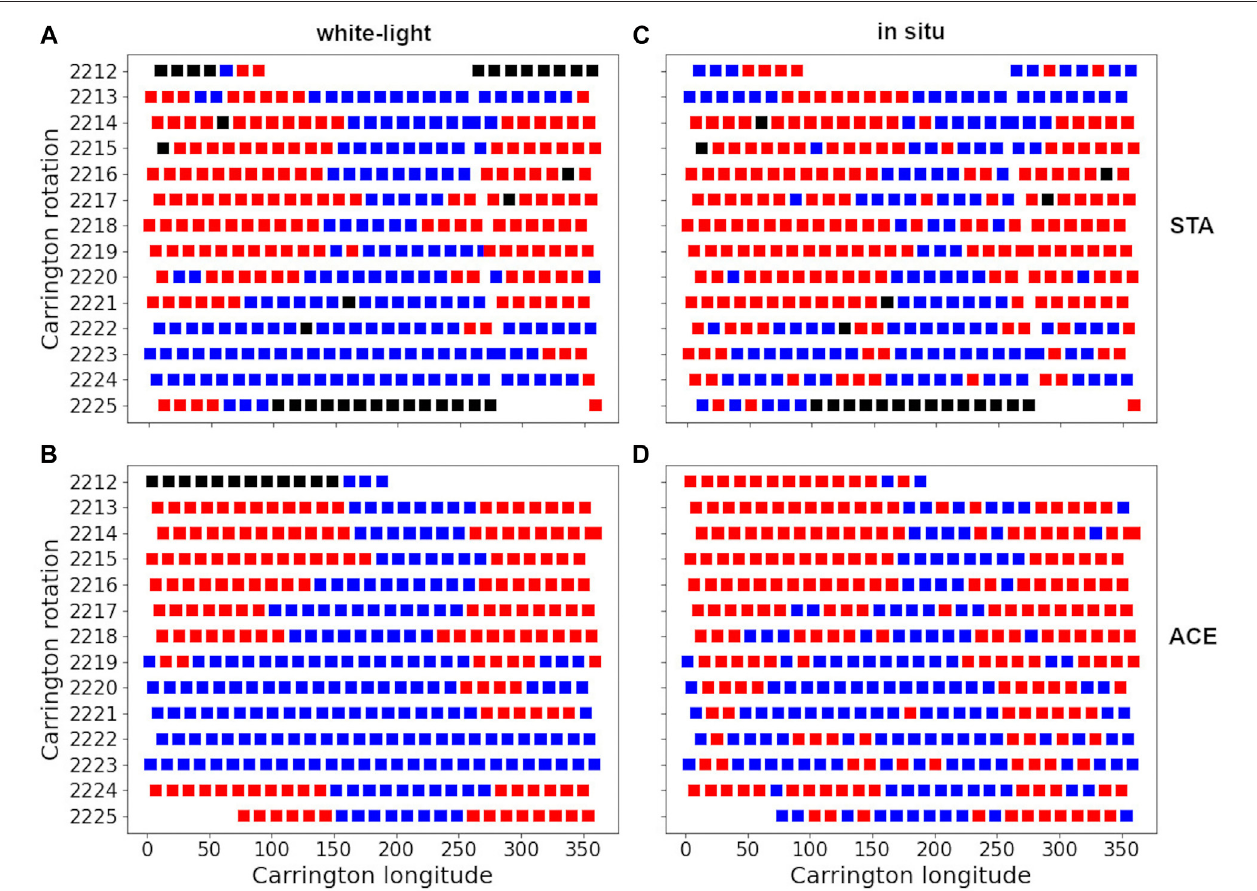
FIGURE 6 | Bartel ’ s diagrams constructed with the SMB lines from the WL observations, for STEREO -A (A) and ACE (B) . Bartel ’ s diagrams using direct in situ polaritymeasurementstakenoverthefullyear2019at STEREO -A (C) and ACE (D) .Blueand redcolorsindicatepositiveand negativepolaritiesrespectively(darkcolors correspond to data gaps).